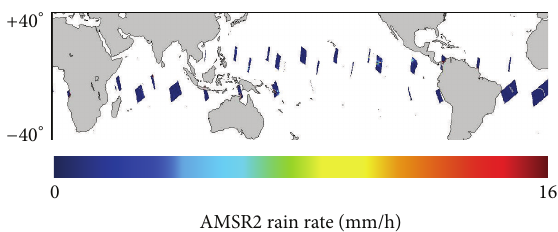
Figure 5: A 5-month AMSR2 rain rates (mm/h), retrieved with the new algorithm, collocated within 10-minute time difference with RSS TRMM Microwave Imager rain rates for 2012.